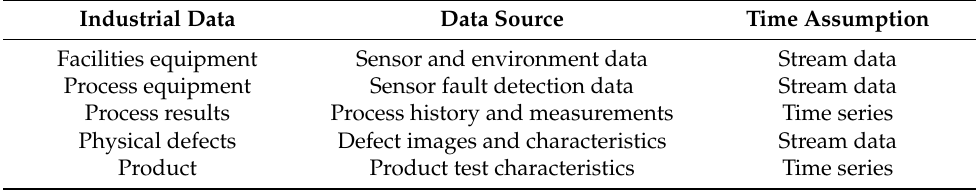
Table 4. Time assumptions for industrial